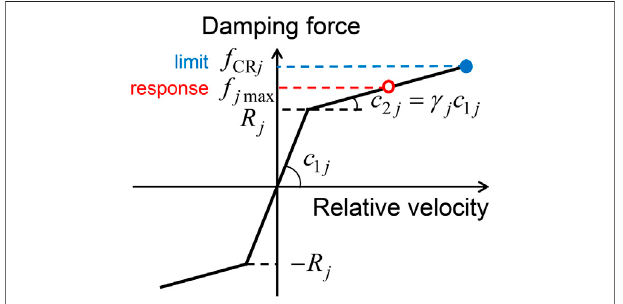
FIGURE 2 | Damping force-relative velocity relation of nonlinear fl uid viscous damper (FVD, often called oil damper) (Adachi et al., 2013).